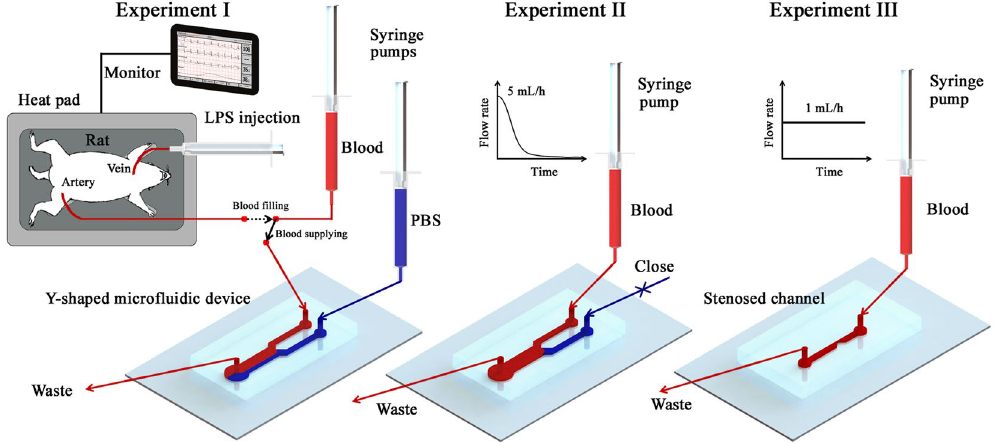
Figure 1. Measurement procedure of the microfluidic system for monitoring blood viscosity, RBC aggregation and platelet adhesion. A rat extracorporeal conduit is established by connecting the artery of a rat and a microfluidic conduit. By manipulating a three-way valve, blood in the rat artery is filled in the syringe and supplied into the microfluidic devices. Viscosity of blood sample is measured by inducing an interfacial line between a reference PBS solution and test blood sample in the Y-shaped microfluidic device (Experiment I). After measuring viscosity variation according to shear rate, Experiment II is carried out to measure RBC aggregation while the inlet of PBS solution is closed. Flow rate of test blood sample is reduced from 5 mL/h to 0 mL/h to induce the formation of RBC aggregates. For the estimation of platelet adhesion, Experiment III is performed by connecting a microfluidic channel with stenosis (90% severity) into the rat extracorporeal conduit. Flow rate of the blood sample is maintained at 1 mL/h during Experiment III.